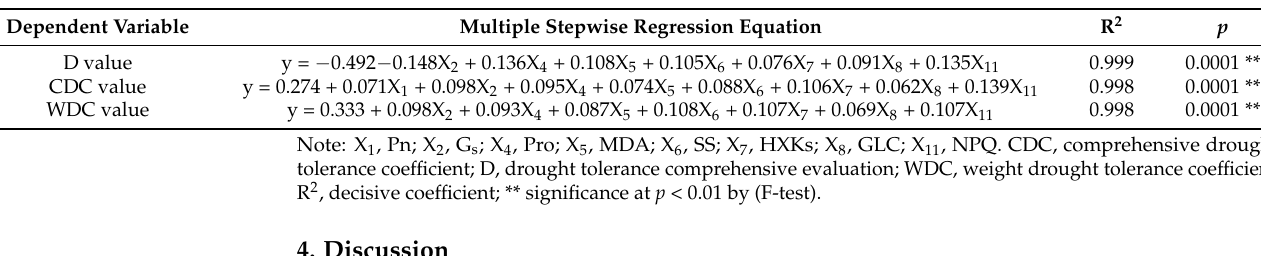
Table 5. Drought tolerance model